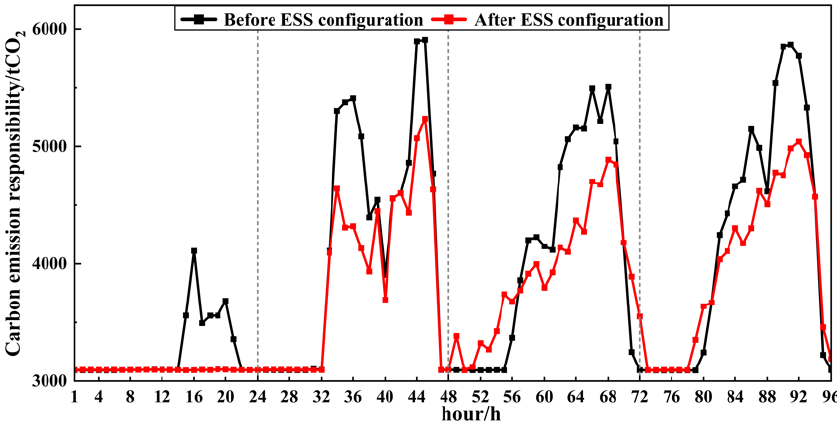
Figure 10. Total carbon emission responsibility before and after the EES configuration.